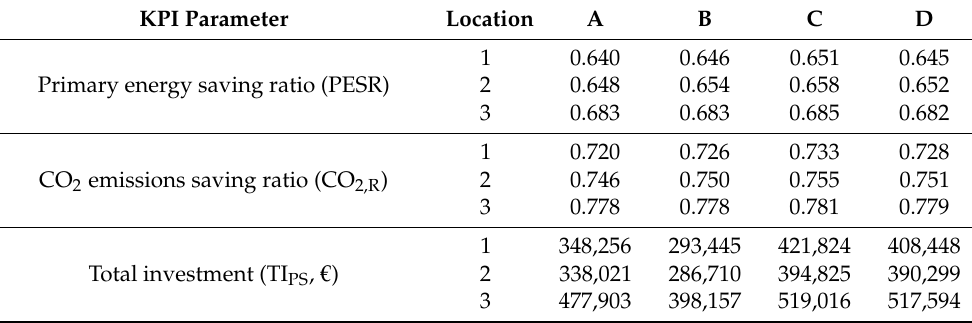
Table 10. Performance analysis of the proposed configurations for each